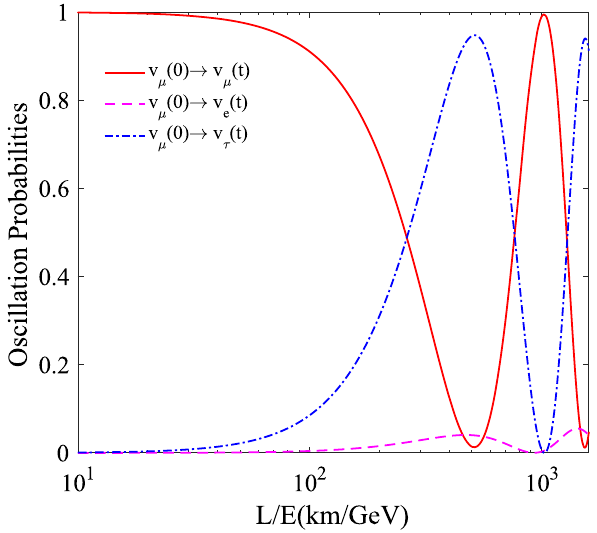
Fig. 4 Oscillation probabilities as a function of the ratio between the traveled distance L and the energy E . The figure plots the oscillation probability v μ ( 0 ) → v μ ( t ) (red, solid line), v μ ( 0 ) → v e ( t ) (purple, dashed line), v μ ( 0 ) → v τ ( t ) (blue, dashed-dotted line) when the initial neutrino flavor is muon flavor